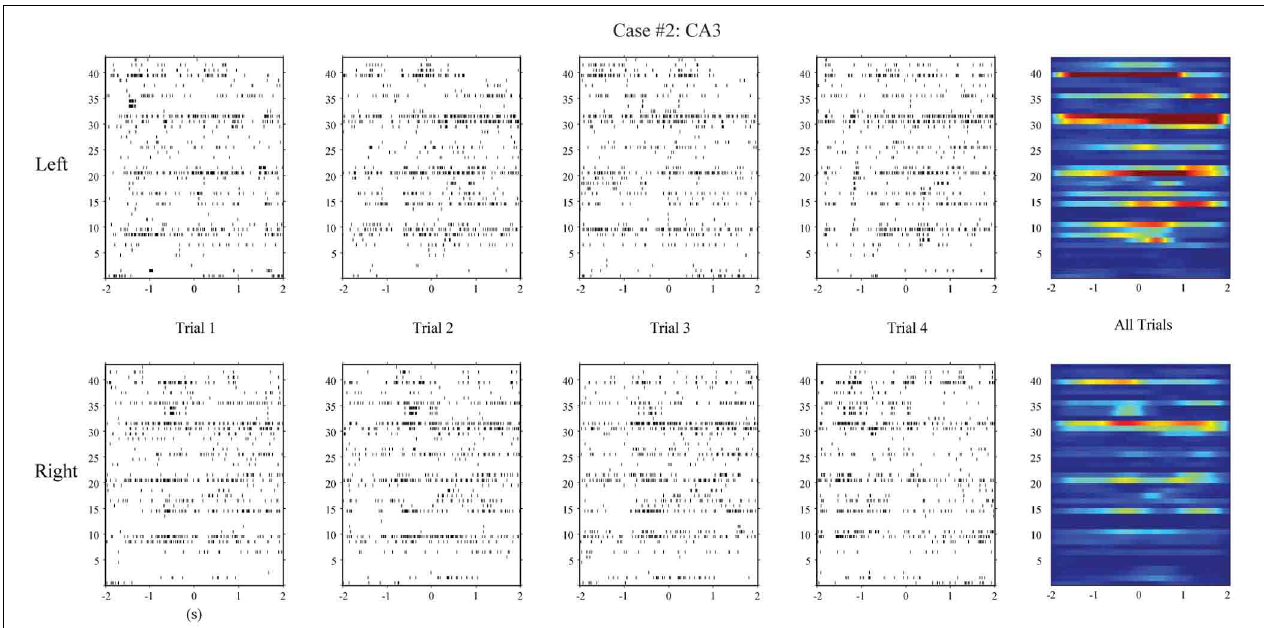
FIGURE 5 | Hippocampal CA3 spatio-temporal patterns from a different animal (case